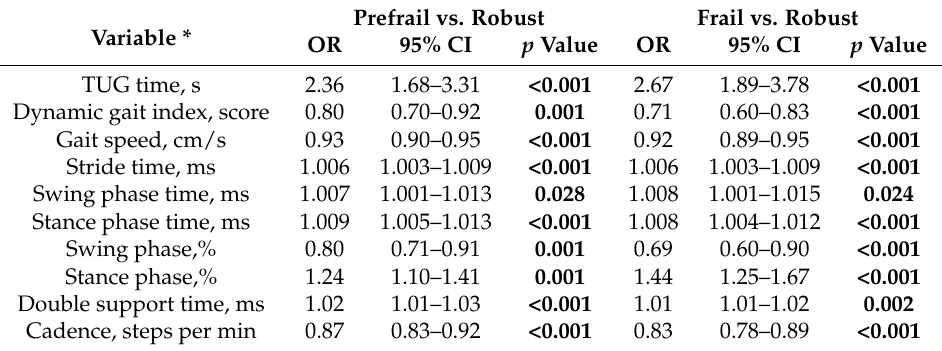
Table 4. The parameters for discriminating three frailty levels (robust, prefrail, and frail). Prefrail vs. Robust Frail vs. Robust